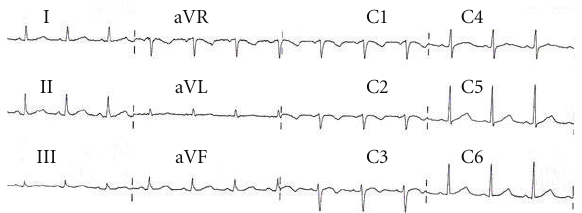
Figure 5: ECG one month later: sinus rhythm (82bpm), QTc 478ms.